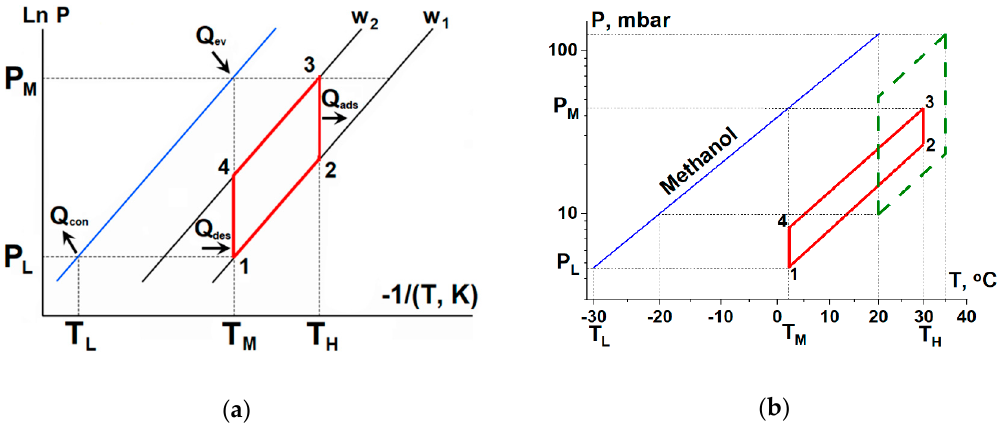
Figure 1. P - T diagrams of 3T HeCol working cycles: ( a )—general one and ( b )—for the “Maxsorb III—methanol” working pair (dashed line—cycle 1, solid line—cycle 2; see the text).